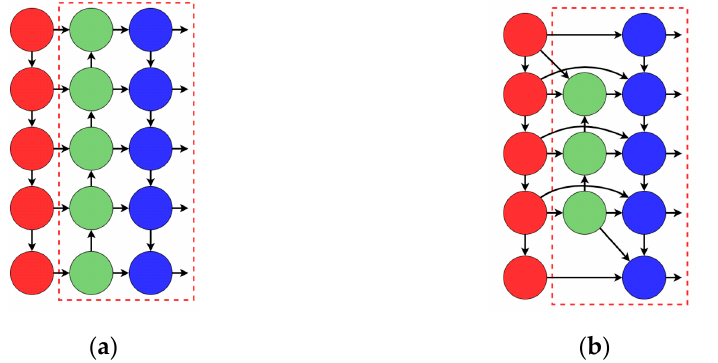
Figure 11. ( a ) Schematic diagram of PANet network; ( b ) schematic diagram of BiFPN network.